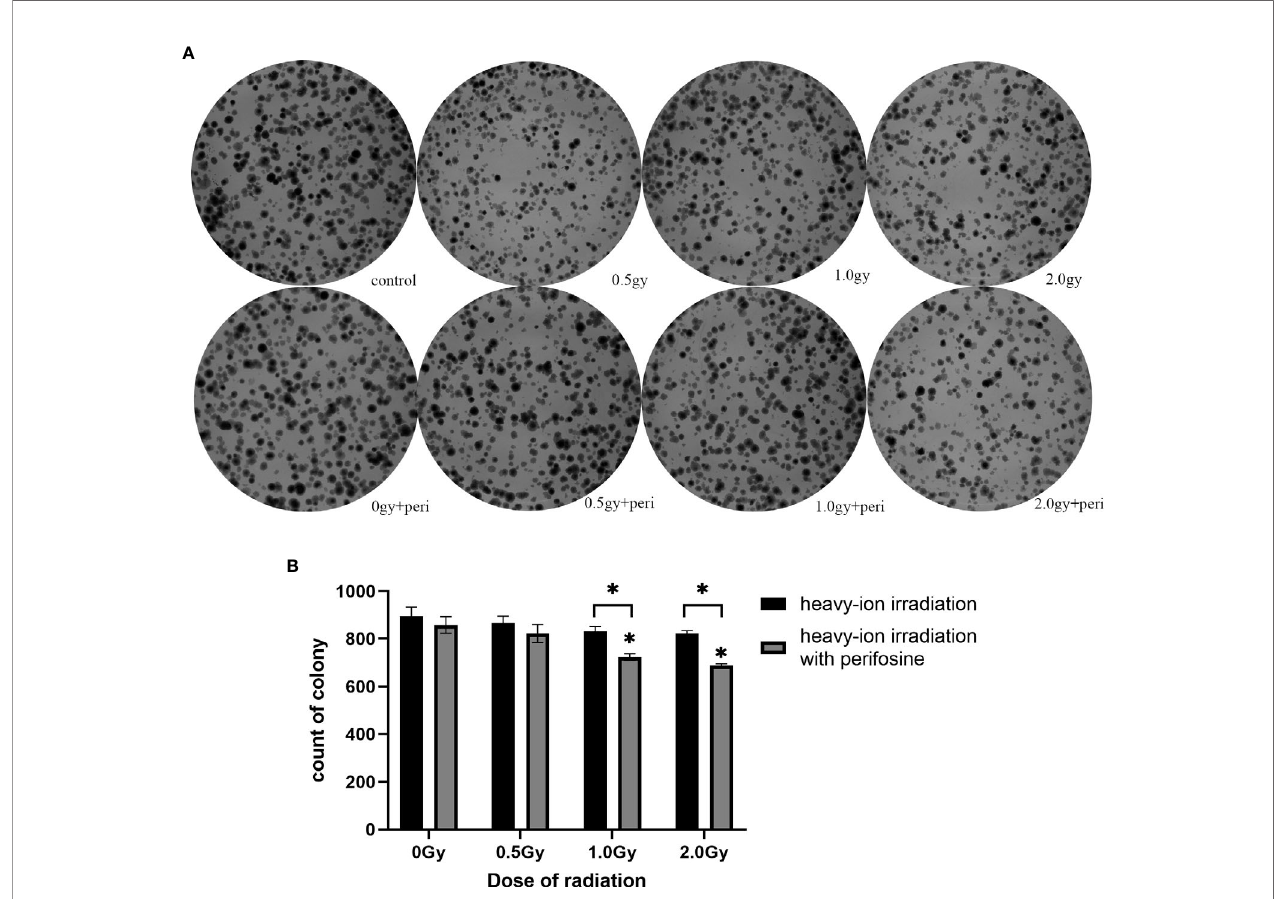
FIGURE 2 | (A) Representative images showing colonies formed in different groups. (B) Quantitative analysis of the numbers of colonies formed by different groups of cells. Data shown are means from three independent experiments. * p < 0.05 vs. control or other